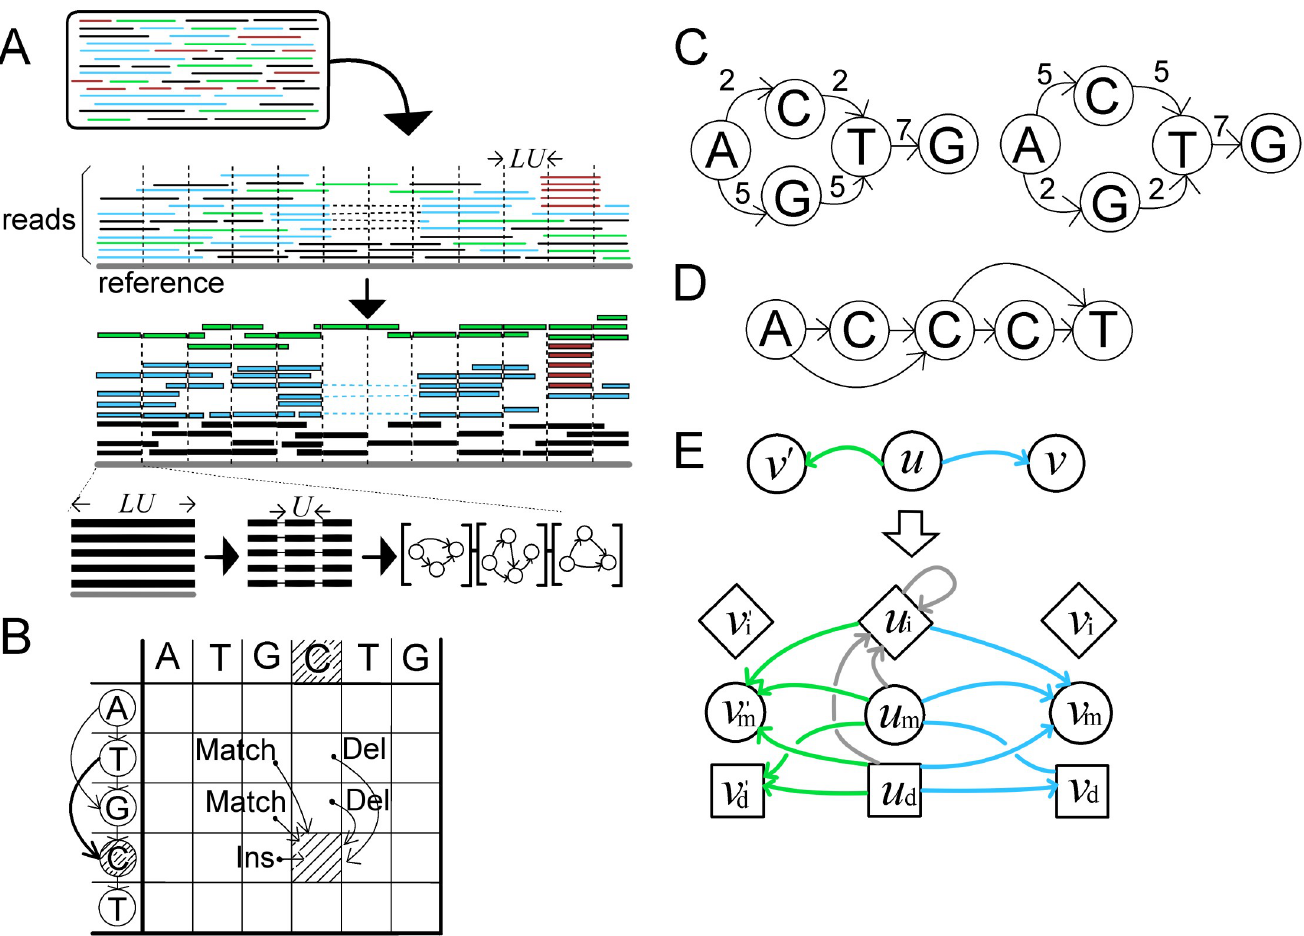
Fig 1. Schematic illustrations of the proposed method. (A): Overview of our workflow. LU is the length of a section, which we split into smaller chunks with U -bp length. There are reads from different multipartite structures, and we represent them by different colors (blue, green, red, and black). (B): An example of dynamic programming matrices for partial order alignments (POA). (C): Two POA graphs with the same structure but with different weights on edges. When aligning AGTG or ACTG, these two graphs display the same alignment unless we consider the weights on the edges. (D): A POA graph with a homopolymer run. Due to sequencing errors, it has two short-circuiting edges. (E): The rule to convert a POA graph into a hidden Markov model (HMM).